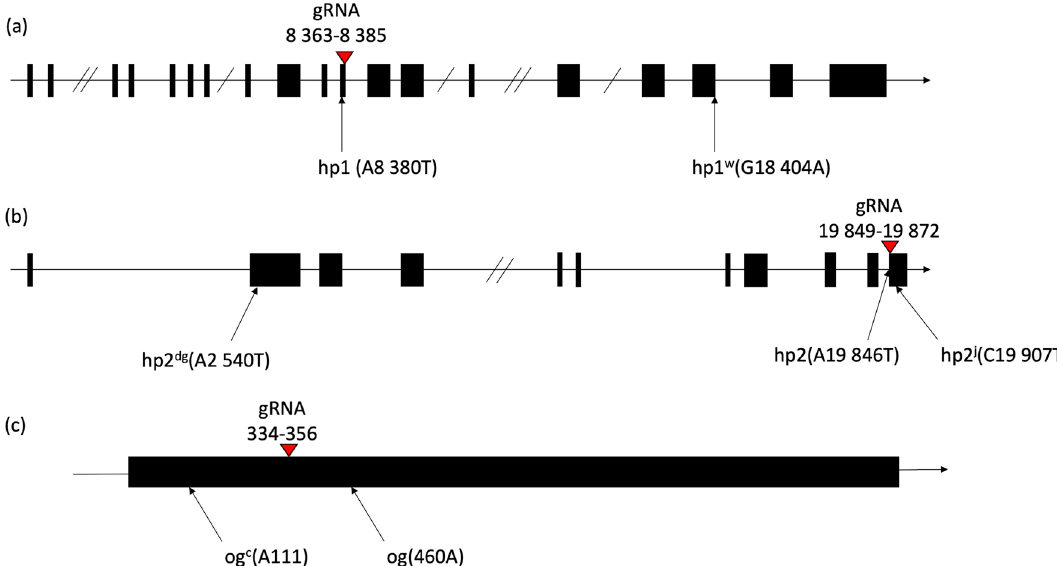
Figure 1. Representation of SlDDB1, SlDET1 and SlCYC-B target sites. Schematic representation of each candidate gene, ( a ) SlDDB1 , ( b ) SlDET1 and ( c ) SlCYC-B , with the previously described mutations and their corresponding annotations with mutation position compared to the first nucleotide of start codon on gene sequence. Black boxes represent exons regions and lines represent introns or UTR regions. Double slashes in introns represent reduction of the intron size. The red triangles represent the site targeted by the Target-AID with their corresponding nucleotides localization on